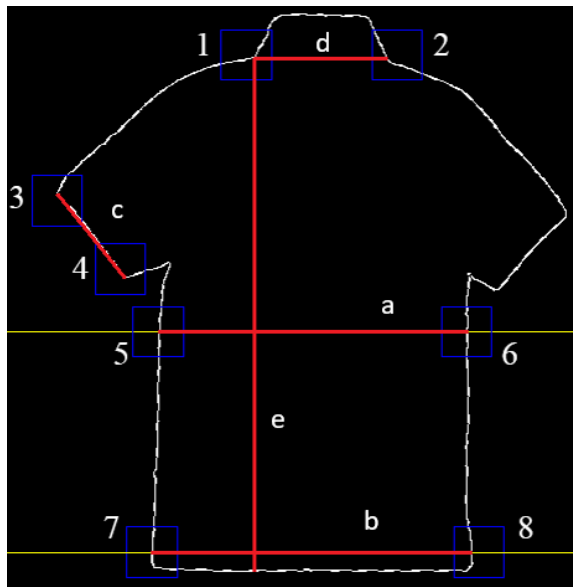
Figure 15. Predefined recognition regions and corresponding dimensions.